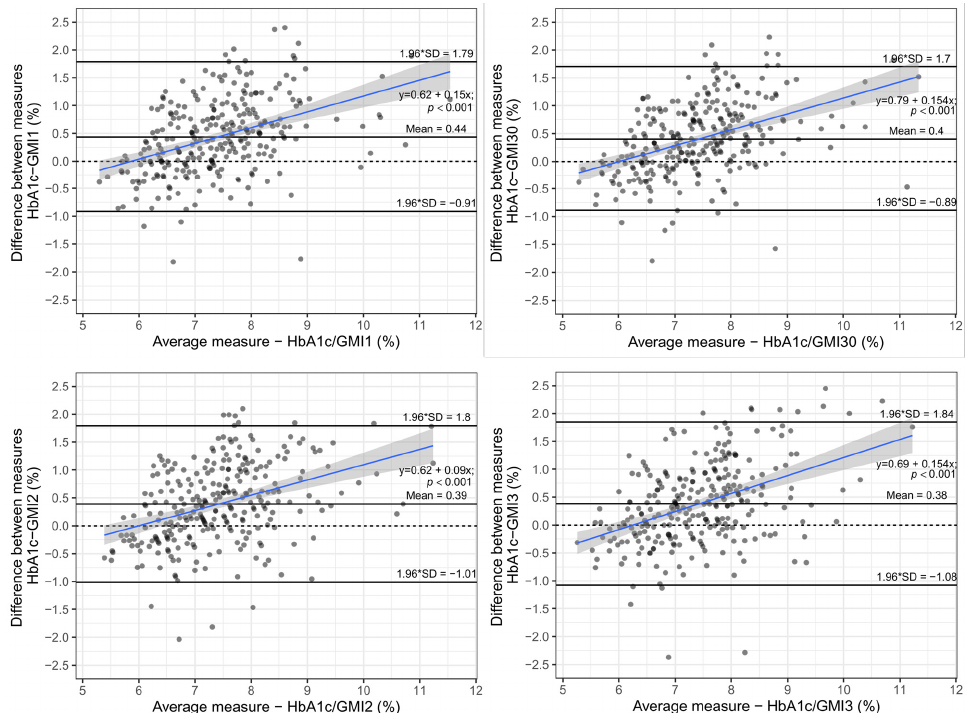
Figure 2. Bland–Altman plot—Difference between HbA1c and GMI measurements vs. average of two measurements.